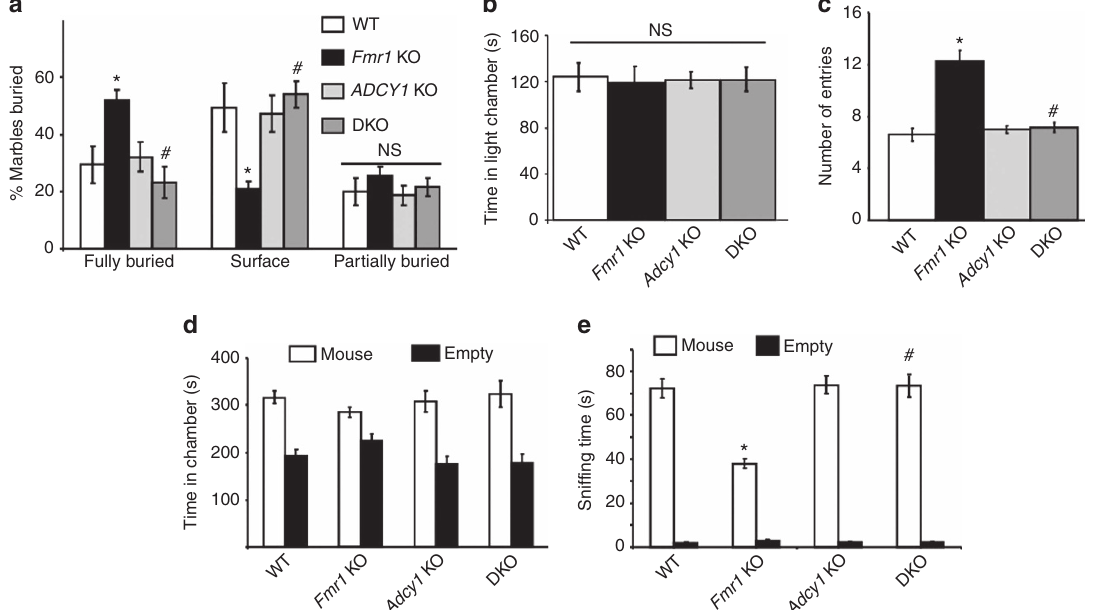
Figure 4 | Genetic removal of Adcy1 attenuates autism-related symptoms in Fmr1 KO mice. ( a ) Marble burying test with WT ( n ¼ 10), Fmr1 KO ( n ¼ 15), Adcy1 KO ( n ¼ 10) and DKO ( n ¼ 17) mice. The % of fully buried, surface and partially buried marbles was recorded. ( b , c ) In the light/dark test, the time spent in the lit chamber ( b ) and the number of entries to the lit chamber ( c ) were recorded in WT ( n ¼ 12), Fmr1 KO ( n ¼ 12), Adcy1 KO ( n ¼ 12) and DKO ( n ¼ 9) mice. ( d , e ) The 3-chamber social interaction test was performed with WT ( n ¼ 11), Fmr1 KO ( n ¼ 11), Adcy1 KO ( n ¼ 10) and DKO ( n ¼ 10) mice. Time spent in the chamber having the stimulus mouse-containing enclosure or the empty enclosure was recorded ( d ). Direct social interaction between the test mouse and the stimulus mouse was determined by the amount of sniffing time during the social interaction test ( e ). *: significant difference between WT and Fmr1 KO group ( P ¼ 0.033 and P ¼ 0.017 for the fully buried and surface marbles, respectively, in a ; P ¼ 0.02 in c ; P ¼ 0.021 in e ). # : significant difference between Fmr1 KO and DKO group ( P ¼ 0.024 and P ¼ 0.013 for the fully buried and surface marbles, respectively, in a ; P ¼ 0.014 in c ; P ¼ 0.019 in e ). The P -values were determined by post-hoc LSD test following ANOVA analysis ( F 3,48 ¼ 3.255, P ¼ 0.037 for fully buried marbles in a ; ANOVA F 3,48 ¼ 3.282, P ¼ 0.036 for surface marbles in a ; F 3,41 ¼ 3.31, P ¼ 0.033 in c ; F 3,38 ¼ 3.054, P ¼ 0.031 in e ). NS: not significant. Data are presented as mean ± behaviour and impaired social interaction were corrected test, all groups showed comparable time spent in the chamber in DKO mice (Fig. 4a–e). In contrast, genetic deletion of Adcy1 that held the stimulus mouse (Fig. 4d). However, direct alone (in Adcy1 KO mice) did not alter these autism-related interaction between the Fmr1 KO mice and the stimulus behaviours (Fig. 4a–e). mouse was significantly reduced (Fig. 4e). Both repetitive